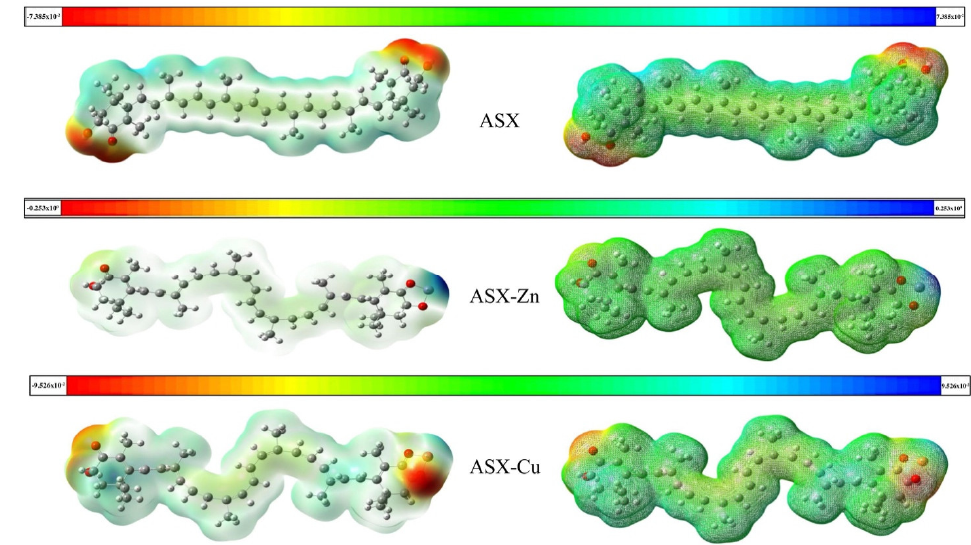
Figure 4. Graphical depiction of molecular electrostatic potentials of astaxanthin ( above ) and astaxanthin with Zn 2+ ( center ) and Cu 2+ ( below ). Variation in color distribution indicate different electrostatic properties (yellow: medium electron-rich site, blue: electron-deficient site, light green: almost neutral site, red: intense electron-rich site, white or grey: zero potential).